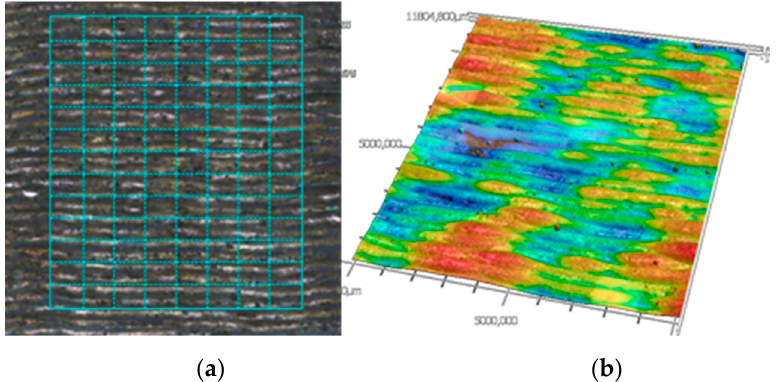
Figure 20. Example of stitching ( a ) and resulting 3D map ( b ) of sample surface 3.